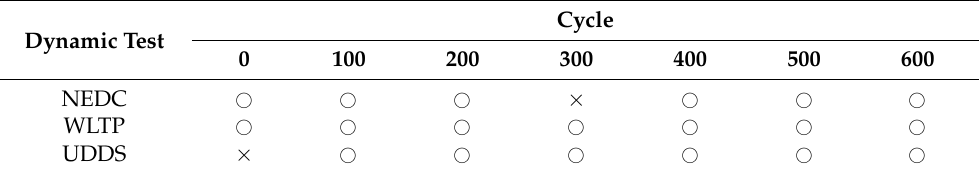
Table 1. The datasets obtained from the battery